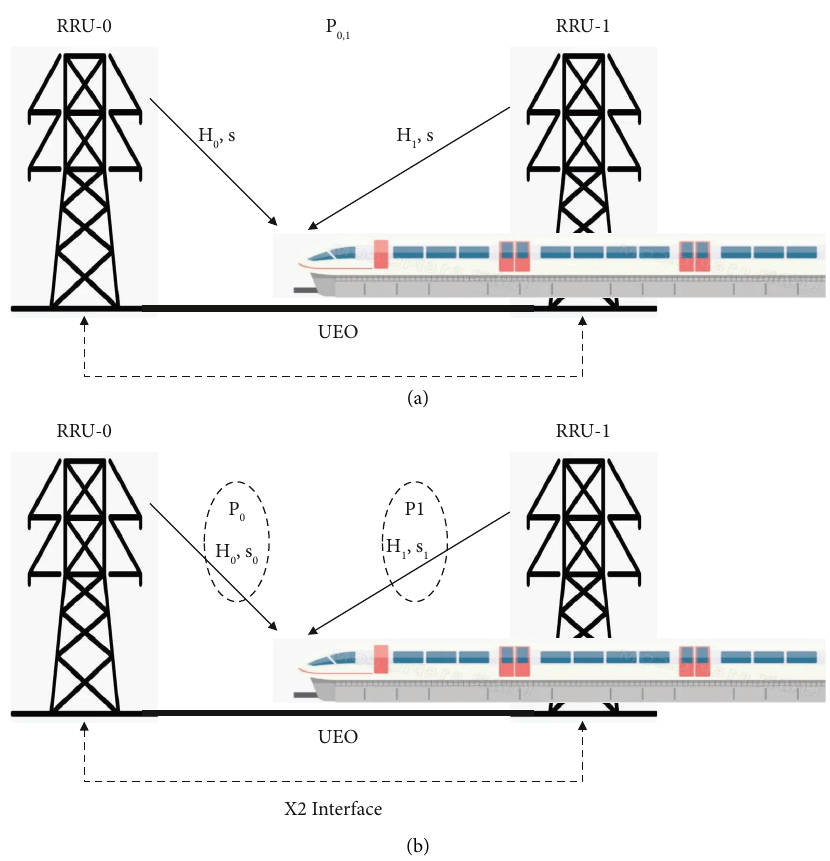
Figure 6: Communication model of train running process (a) Type-0 CoMP model (b) Type-1 CoMP model.